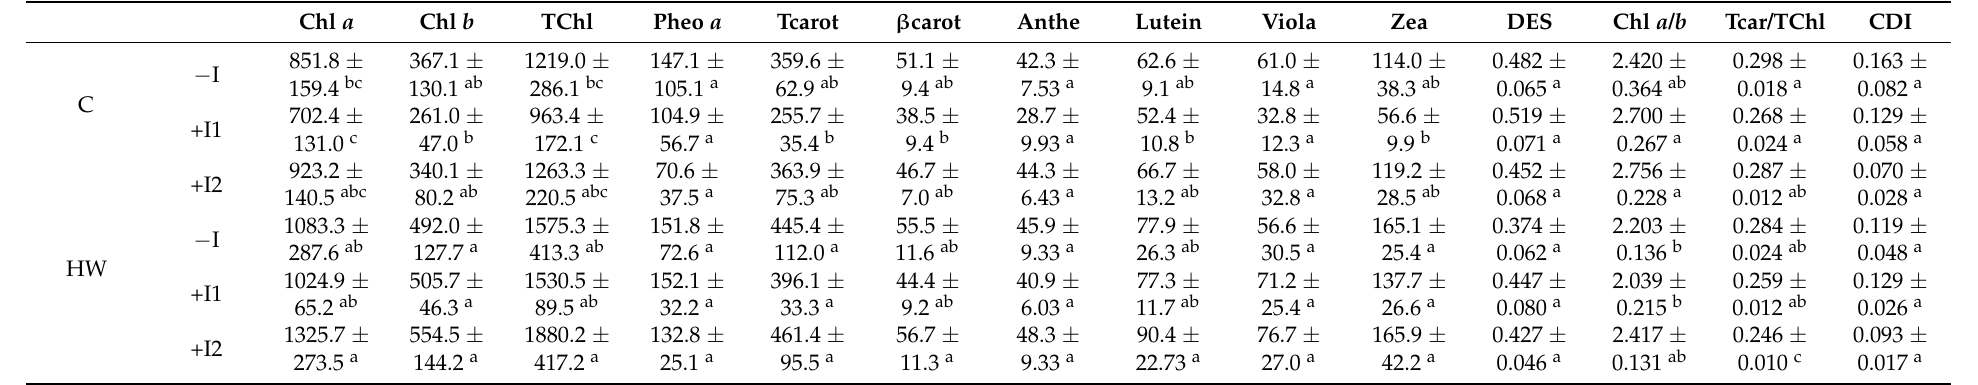
Table 2. Relative concentrations of pigments ( µ g g − 1 FW): chlorophyll a (Chl a ), chlorophyll b (Chl b ), total chlorophyll (TChl), pheophytin a (Pheo a ), total carotenoid (Tcarot), β -carotenoids ( β carot), antheraxanthin (Anthe), lutein, violaxanthin (Viola) and zeaxanthin (Zea); de-epoxidation state (DES), chlorophyll a / b ratio (Chl a/b ), total carotenoid to total chlorophyll ratio (TCar/TChl) and chlorophyll degradation index (CDI), in non-inoculated ( − I) and marine PGPR consortia 1- and 2- inoculated (+I) Vitis vinifera , under normal (control) thermal regimes and exposed to the heatwave (HW) (average ± standard deviation, N = 5, letter